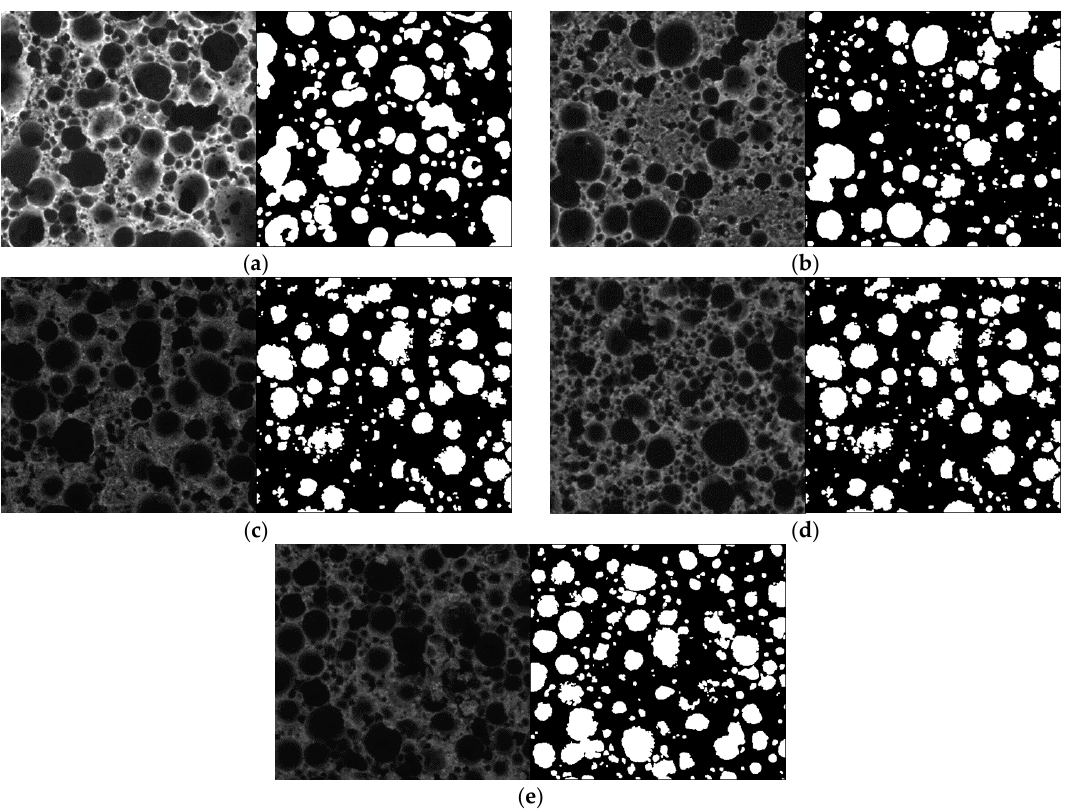
Figure 5. Optical microscope image analysis for porosity measurement of foam composite. ( a ) Plain; ( b ) AC5; ( c ) AC10; ( d ) AC15; ( e )